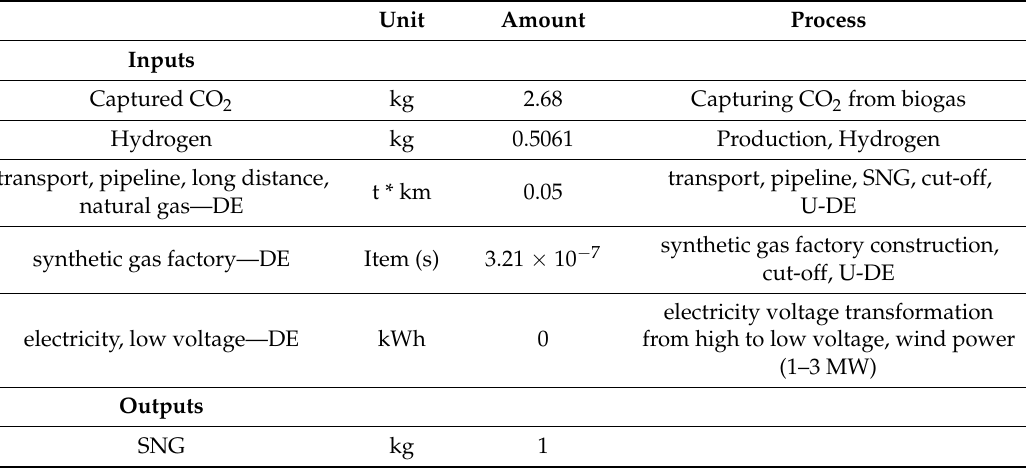
Table A14. Production and Transport, SNG.